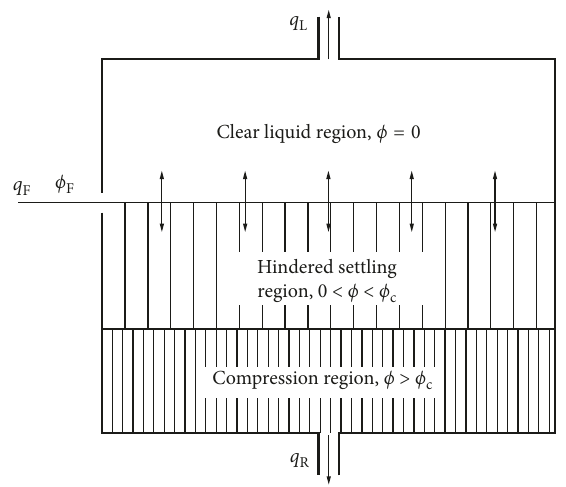
Figure 1: Vertical tailing silo operating at steady state in a con- secutive underflow